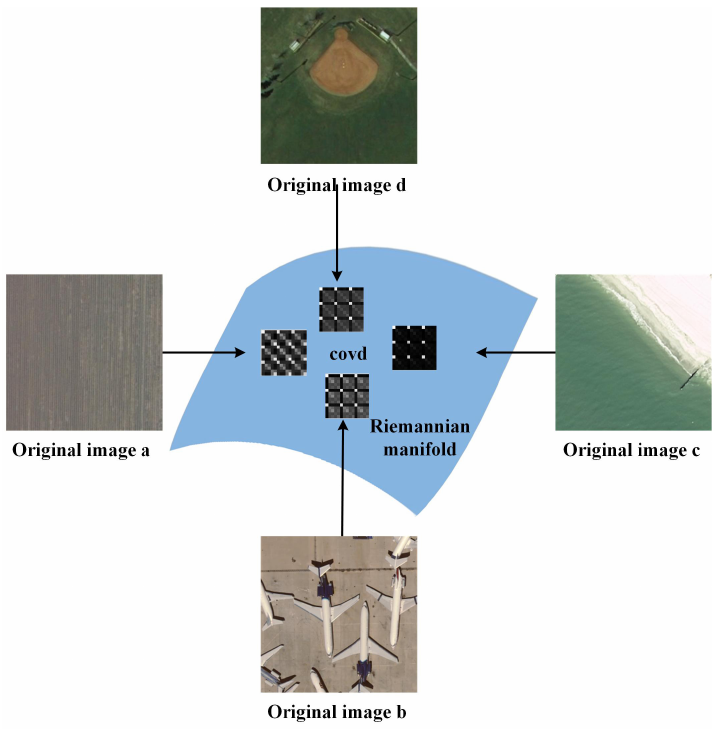
Figure 4. Sample geographic images and corresponding covariance descriptor (covd)